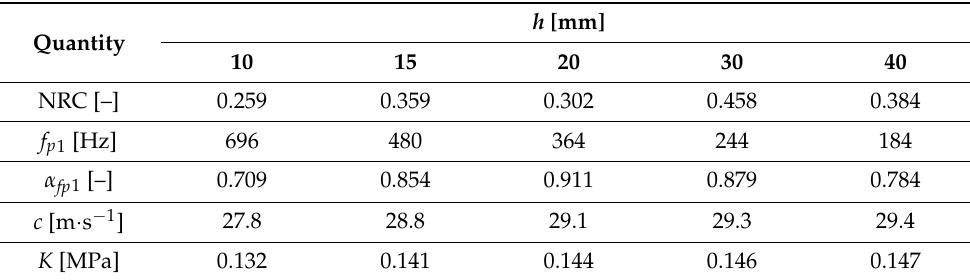
Table 5. Results of measured and calculated acoustical and mechanical quantities for different loose powder bed heights of the applied silica filler.